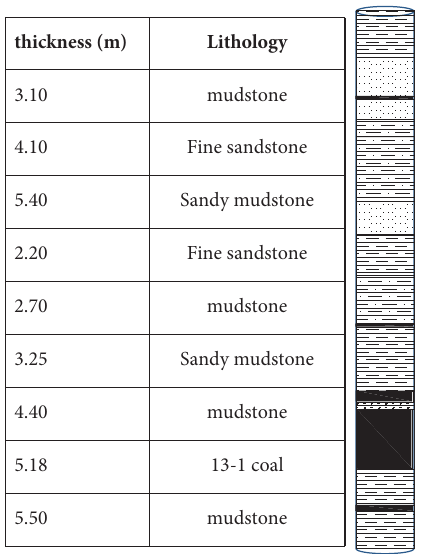
Figure 2: Coal seam comprehensive